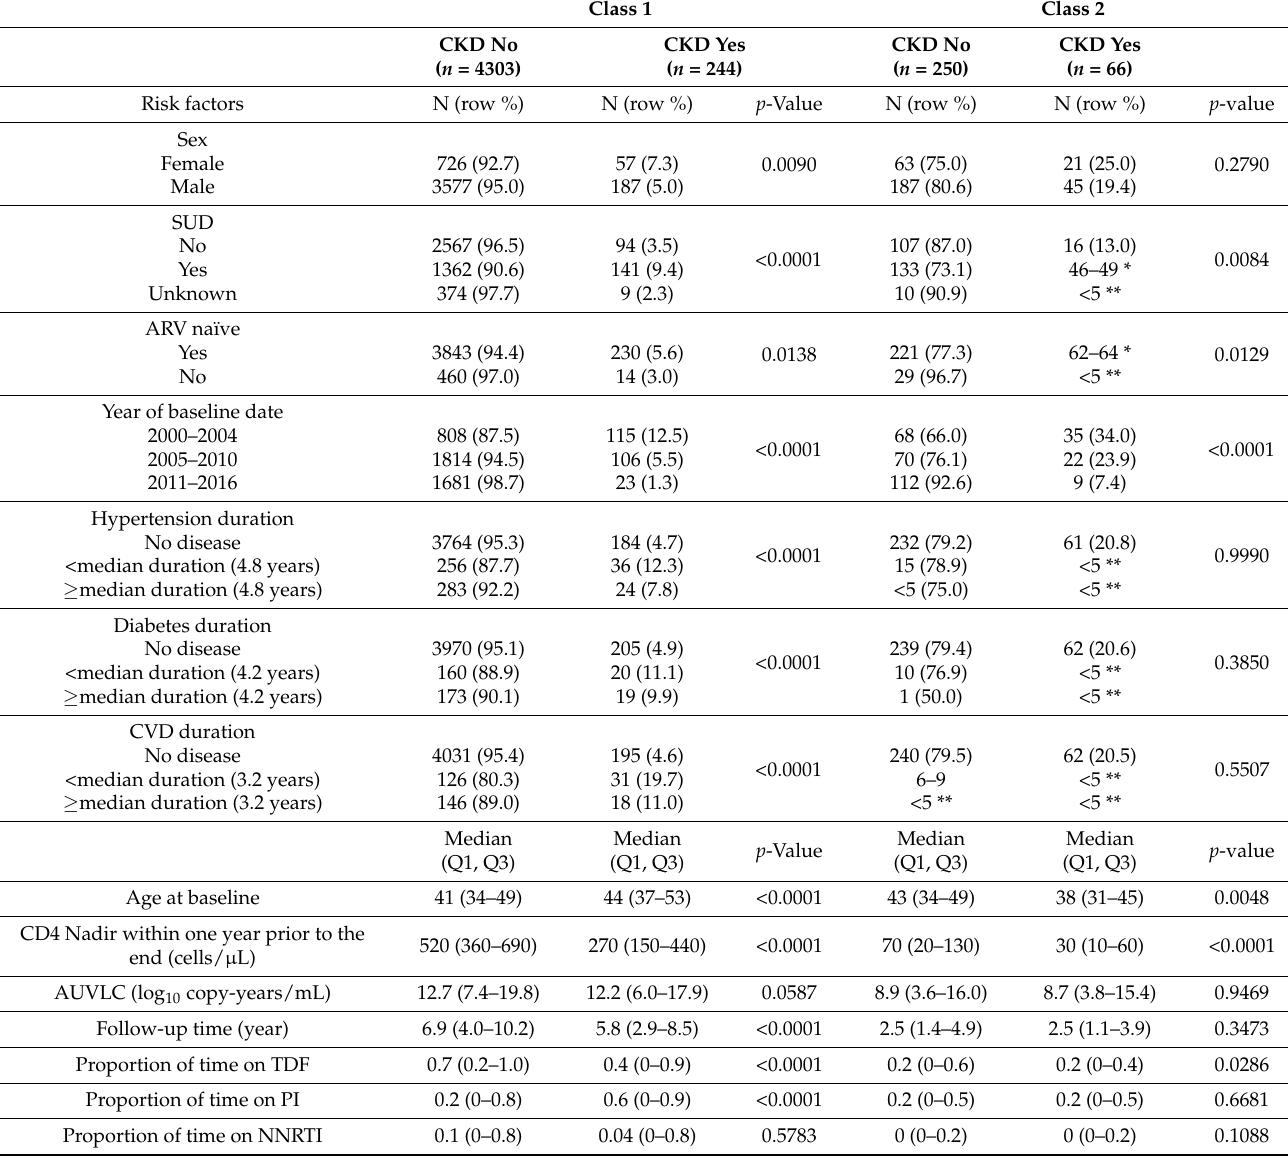
Table 3. Descriptive statistics of the study population by CD4:CD8 class identified by two-class linear model with time-invariant covariates on chronic kidney disease (CKD) status. Class 1 Class